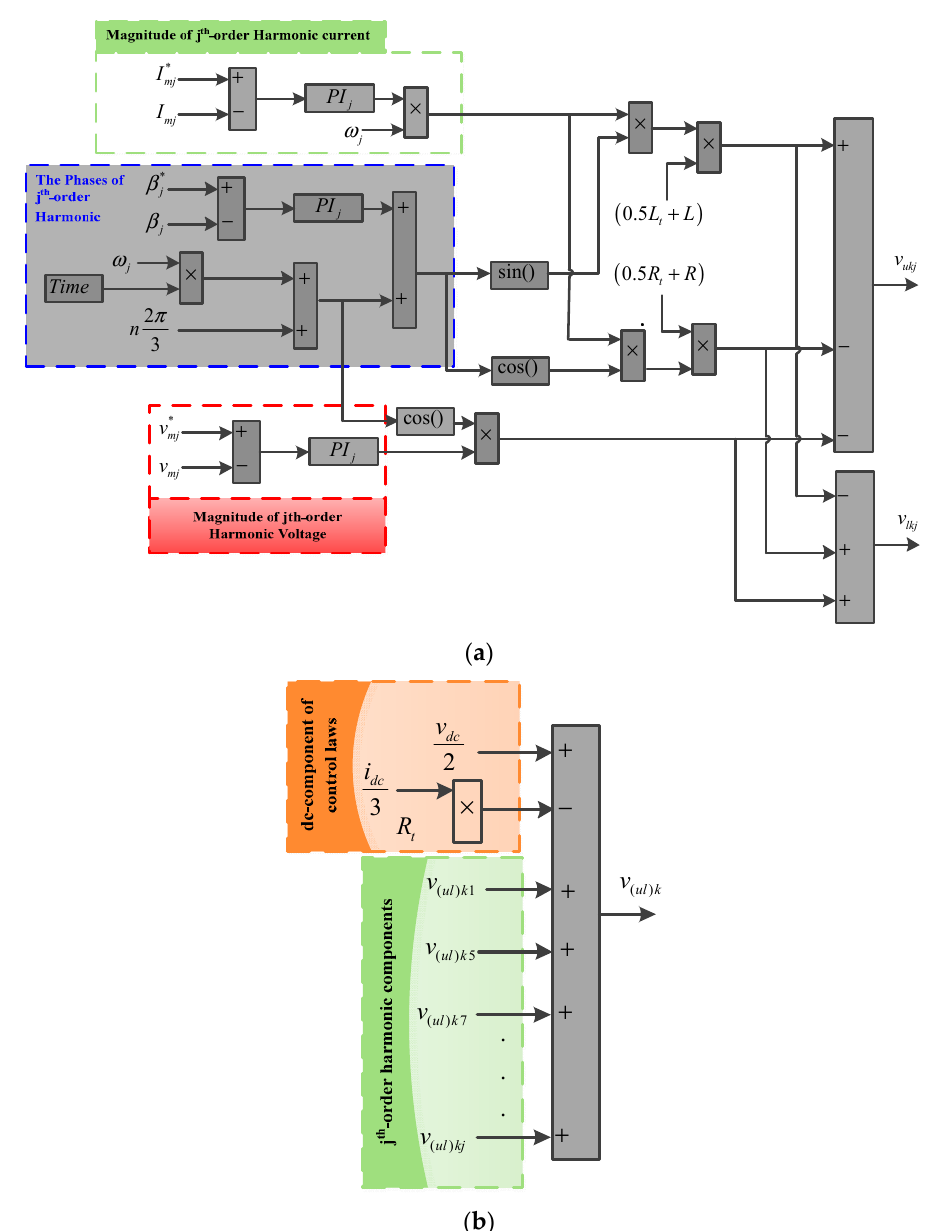
Figure 2. Proposed control strategy under zero circulating currents: ( a ) harmonic components of control laws and ( b ) the control laws.